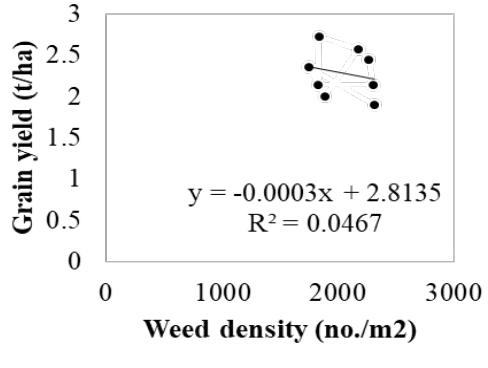
Figure 4: Scattered plot of rain Yield vs Sterility %